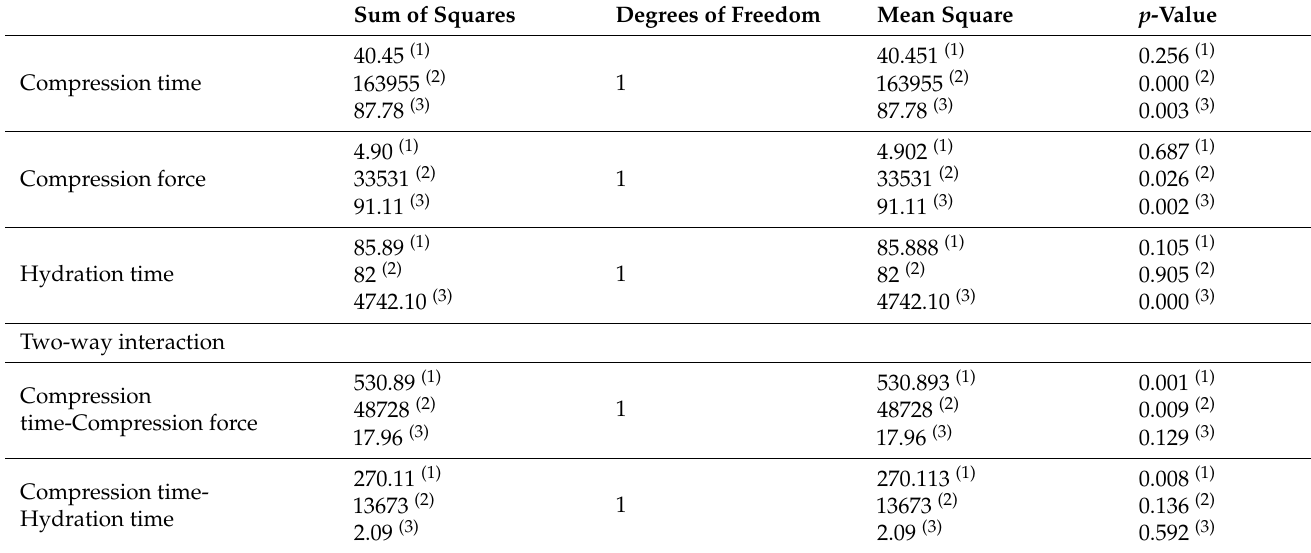
Table 6. Variance analysis DoE II. Sum of Squares Degrees of Freedom Mean Square p